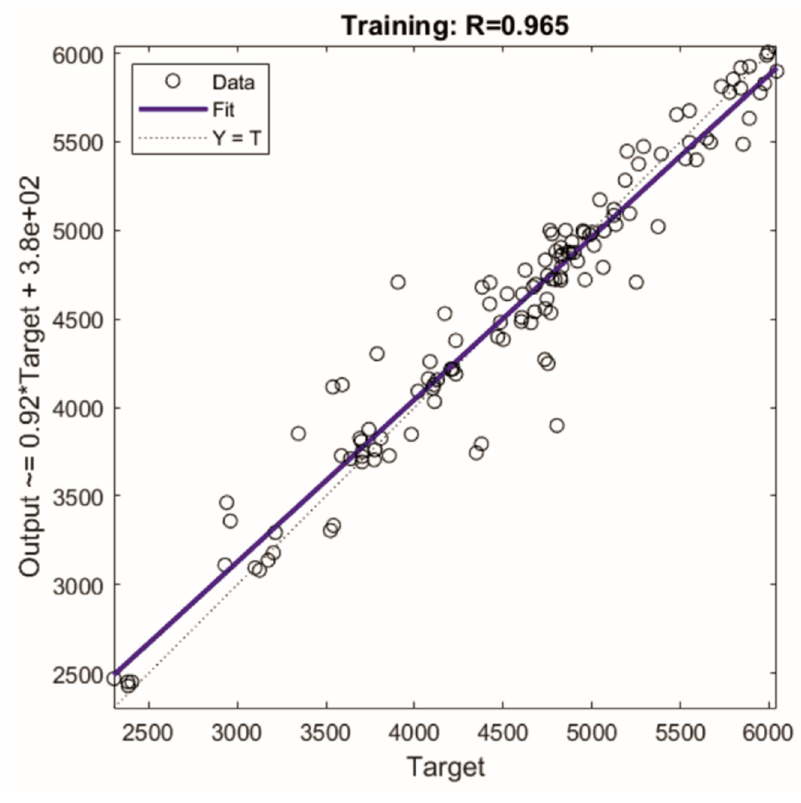
ff ness modulus ANN model. Appl. Sci. 2019 , 9 , x FOR PEER REVIEW